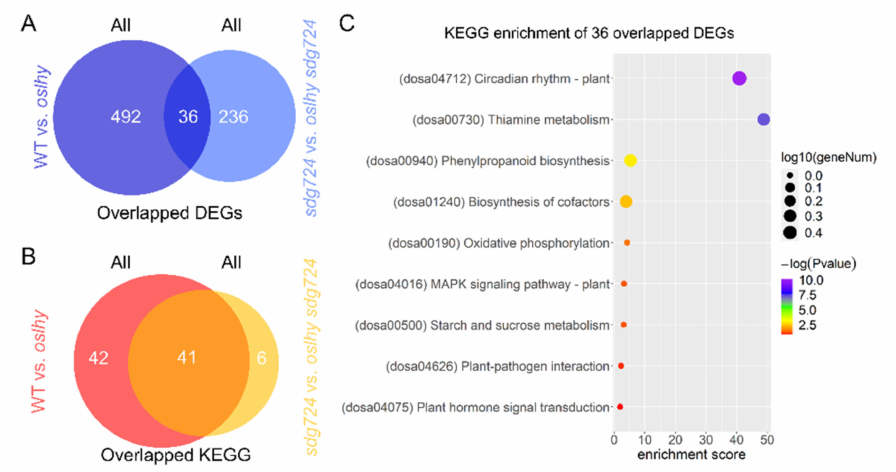
Figure 1. The influence of SDG724 on OsLHY . ( A ) Overlapped DEGs between the WT vs. oslhy and sdg724 vs. oslhy sdg724 comparisons. ( B ) Overlapped KEGG pathways between the WT vs. oslhy and sdg724 vs. oslhy sdg724 comparisons. ( C ) KEGG enrichment of 36 overlapped DEGs between the WT vs. oslhy and sdg724 vs. oslhy sdg724 comparisons. All indicates all of the DEGs.